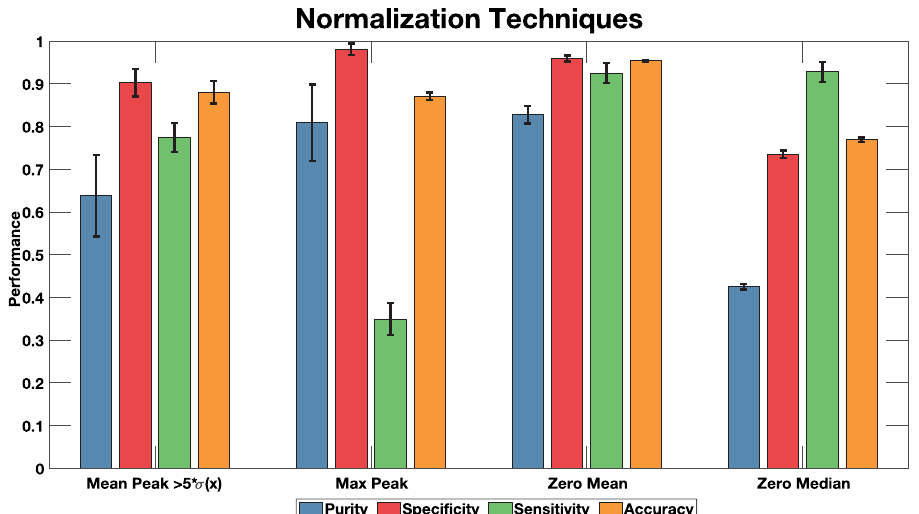
Figure 4. Using an identical experimental setup as the one described in Table 2, four normalization methods were applied to the dataset. However, a key difference is the classification algorithm (EBT) was fixed with the only varying variable being the normalization techniques. The Zero Mean method demonstrated consistently higher performance across all metrics indicating it is best suited for our datasets. Error bars represent one standard deviation across the 286 ensemble of models. Pseudocode of the applied method can be found as Supplementary Fig.